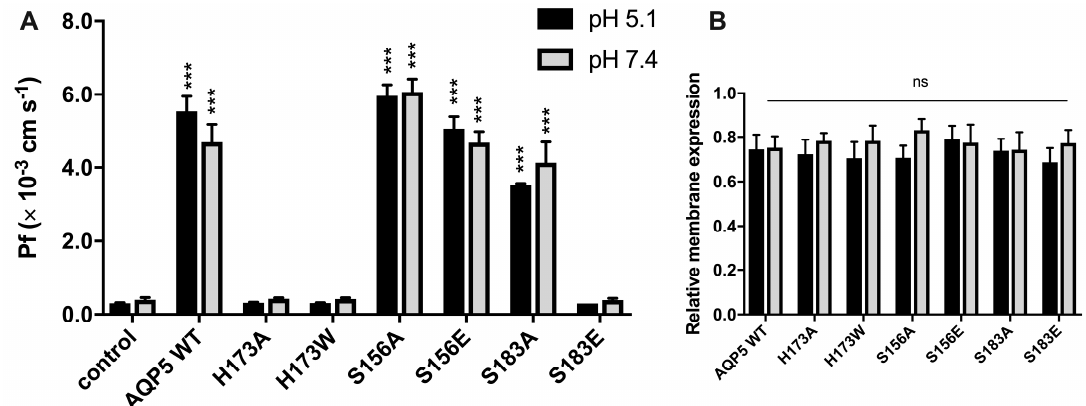
Figure 3. Residues involved in water permeability through AQP5. ( A ) Water permeability coefficients of control and cells expressing AQP5 WT and mutants, performed at 23 °C and pH 5.1 and 7.4. Data are shown as mean ± SEM of 10 measurements; ( B ) Relative membrane expression of AQP5 WT and mutants at pH 5.1 and pH 7.4, calculated from fluorescence intensity profiles (10 cells in each experimental condition, 4 profiles for each cell, from at least 3 independent experiments). Significance levels: ns, non significant, *** p < 0.001, compared to control.